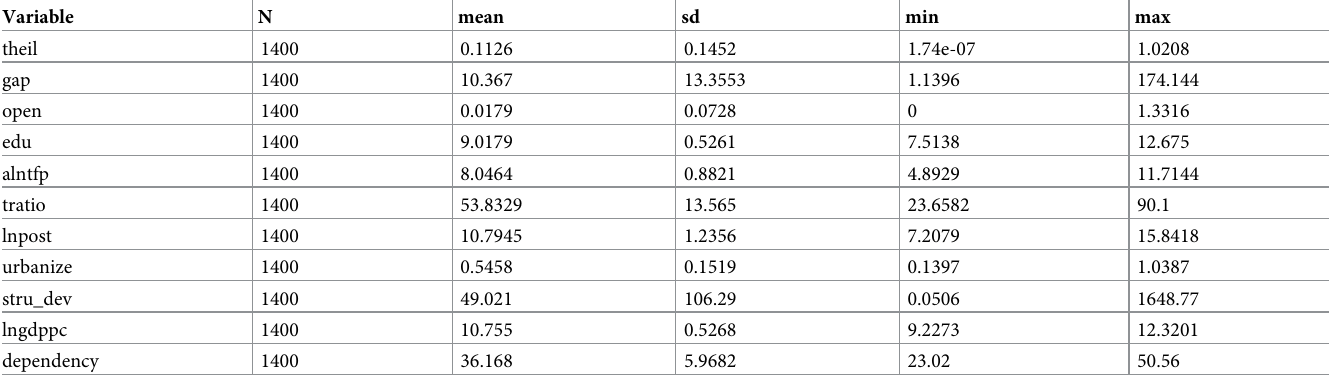
Table 3. Descriptive statistics